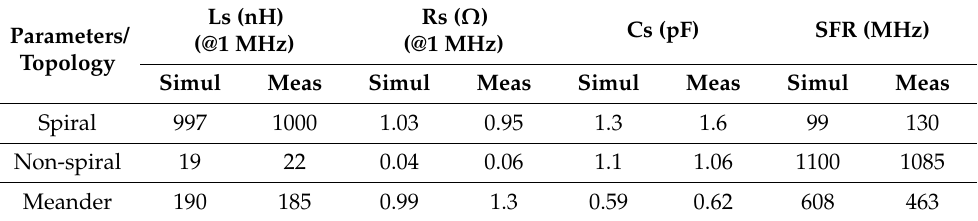
Table 2. Simulated/measured lumped parameter values of the different sensor topologies.